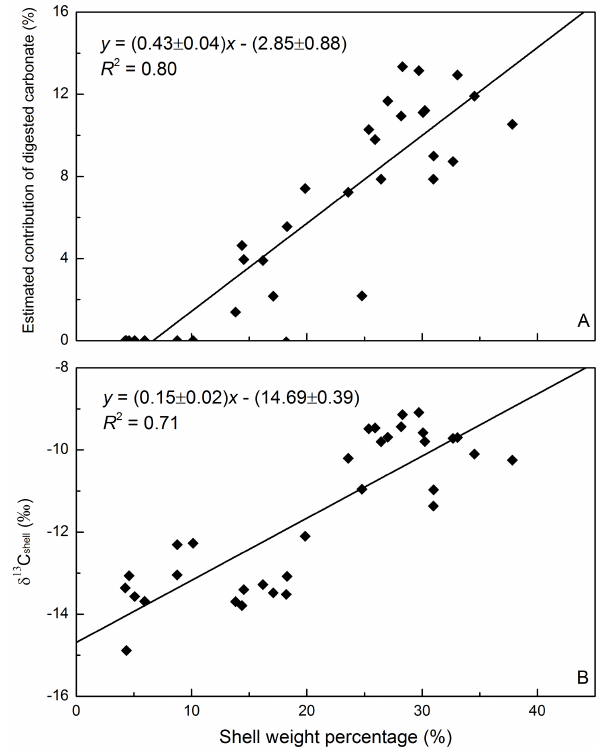
Figure 5. Relationship between (a) estimated contribution of in- gested carbonate and shell weight percentage and (b) δ 13 C of snail shell aragonite and shell weight